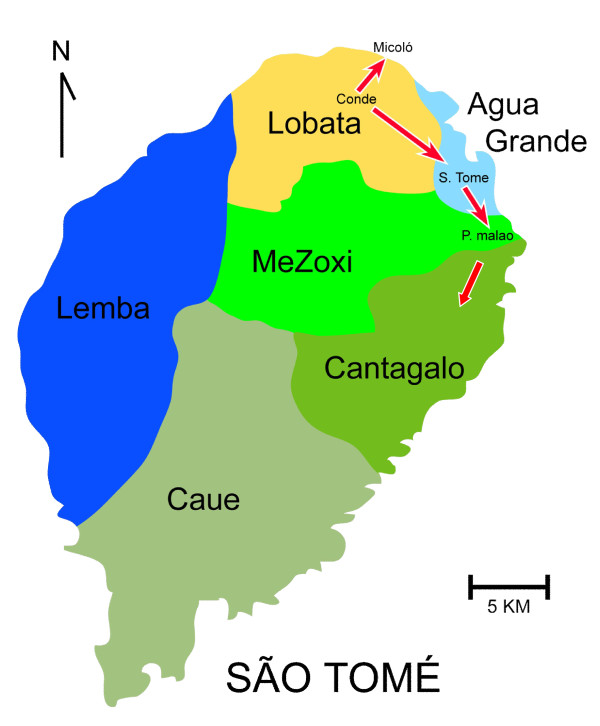
Map for malaria epidemics on the island of São Tomé 2008-2009.